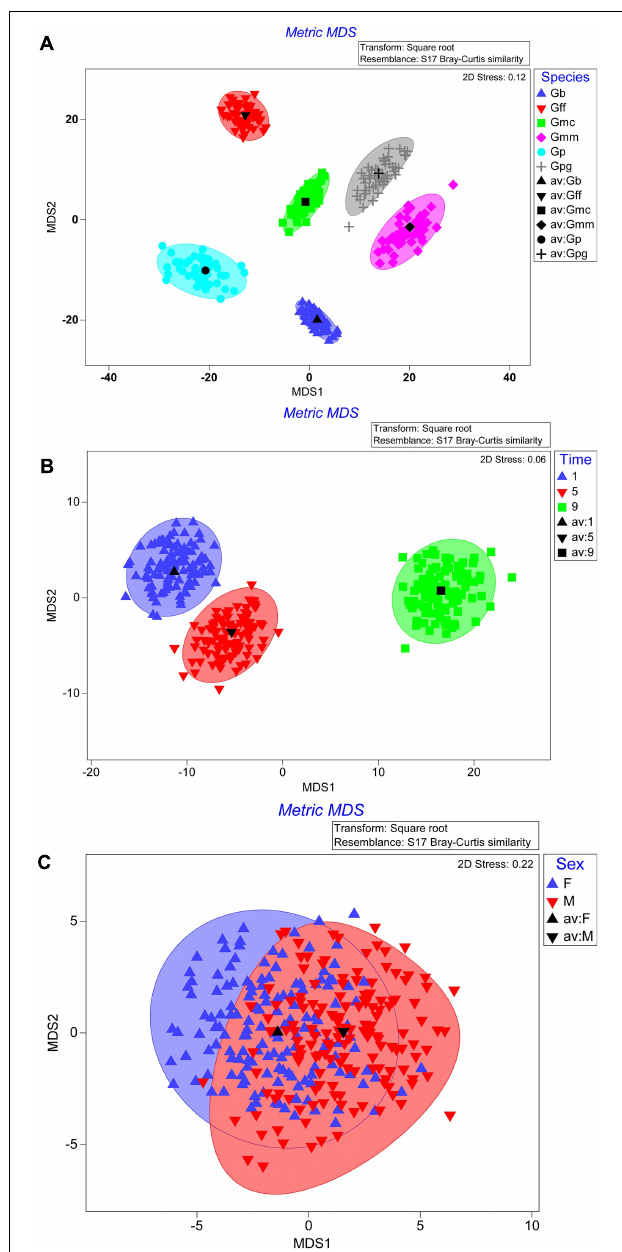
FIGURE 4 | Metric multidimensional scaling (MMDS) of GpSGHV, Wigglesworthia, Sodalis and Wolbachia relative denisty with originations from tsetse species (A) , time post GpSGHV injection (B) , or sex (C) .